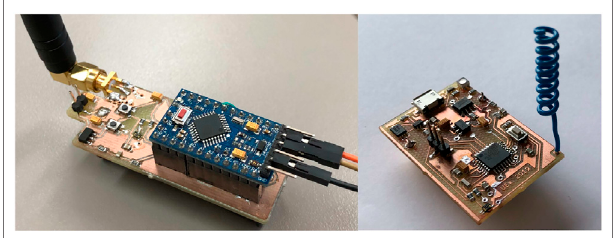
FIGURE 4 | Second and third versions of the